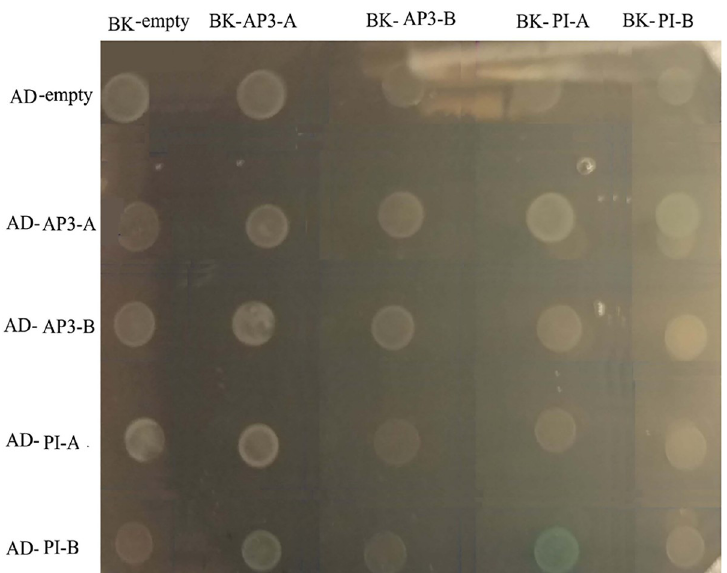
Fig 9. Yeast two-hybrid interactions of five MADS-box B class proteins of S . chinensis . GAL4-based yeast two- hybrid vectors pGADT7 vector (AD) and pGBKT7 vector (BK) and co-transformed into the AH109 yeast strain. Yeast growth on selection plates SD/-Trp-Leu-His-Ade/X- α -GAL solid medium.